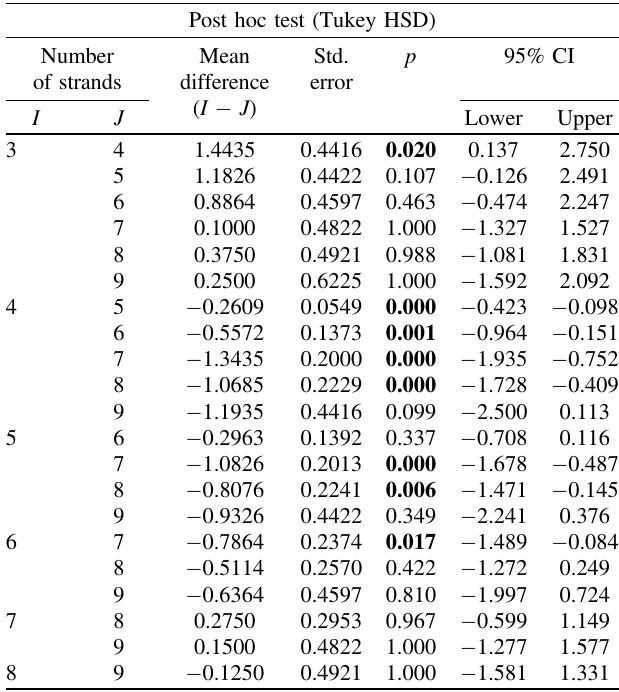
Table 4. Post hoc test (Tukey HSD) – multiple comparisons of number of